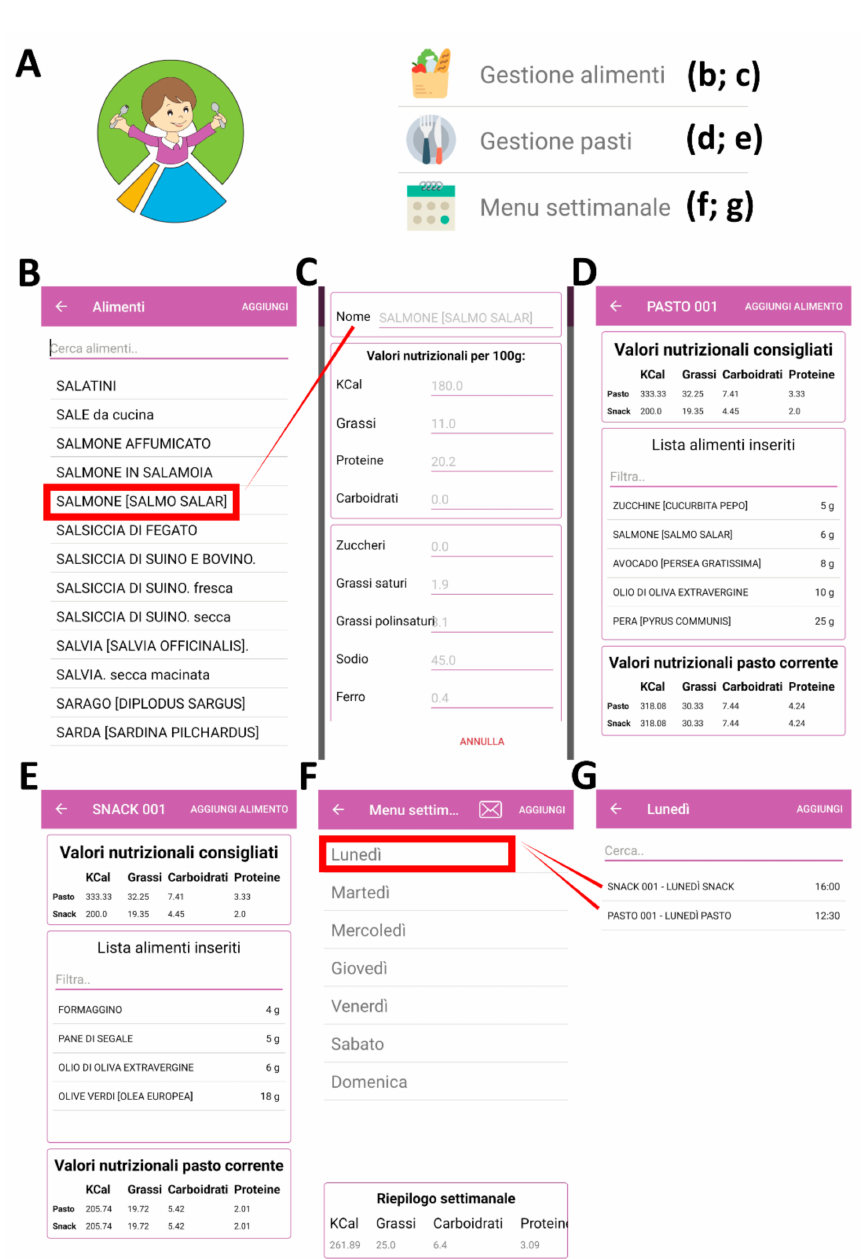
Figure 1. Using the app to learn about the nutritional facts of each food and create new daily or weekly menus. The logo and the first part of the drop-down menu are reported in ( A ). An example of food management (“gestione alimenti”) is reported in ( B , C ). An example of meal management (“gestione pasti”) is reported in ( D , E ). Particularly, in the section dedicated to meal management, the suggested nutritional values (“valori nutrizionali consigliati”) are above the list of inserted food, whereas the selected nutritional values (“valori nutrizionali pasto corrente”) are placed under the list. An example of a weekly menu (“menu settimanale”) with a weekly summary (“riepilogo settimanale”) is reported in ( F , G